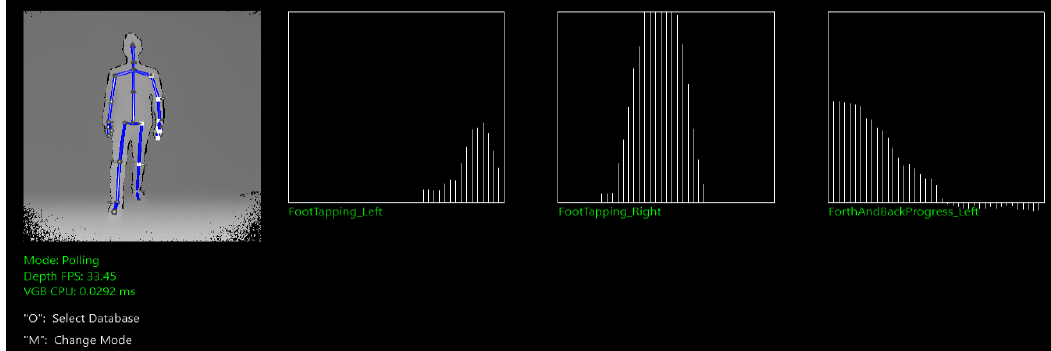
Figure 5. Visualization of the Steps Recognition when the user performs step 5 (right foot